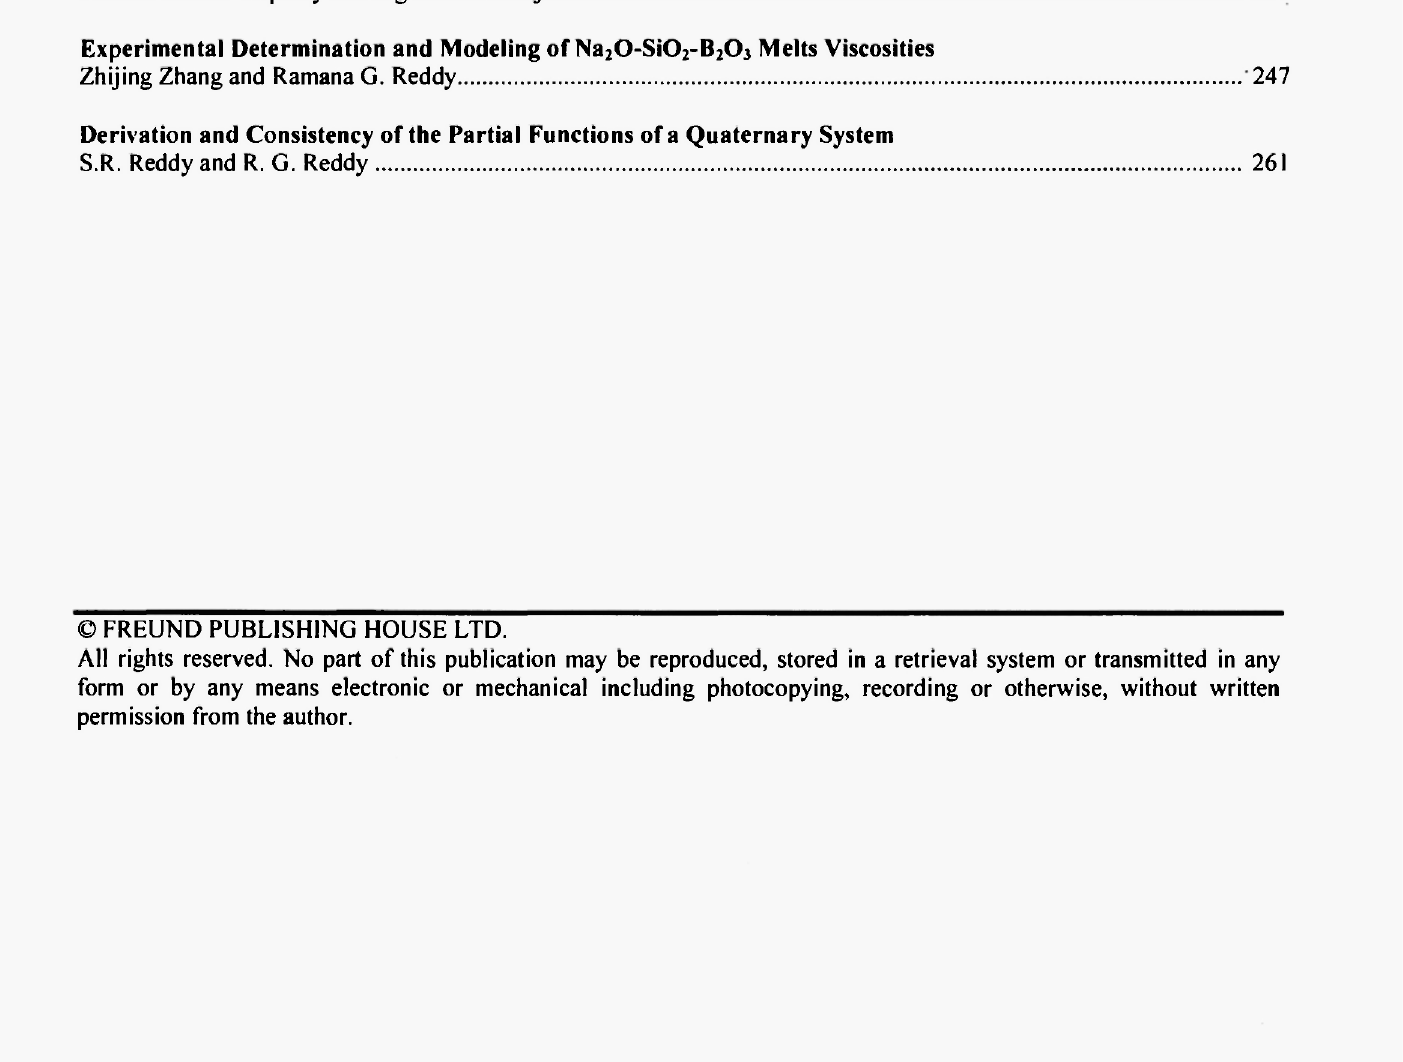
Experimental Determination and Modeling of Na 2 0-Si02-B 2 03 Melts Viscosities